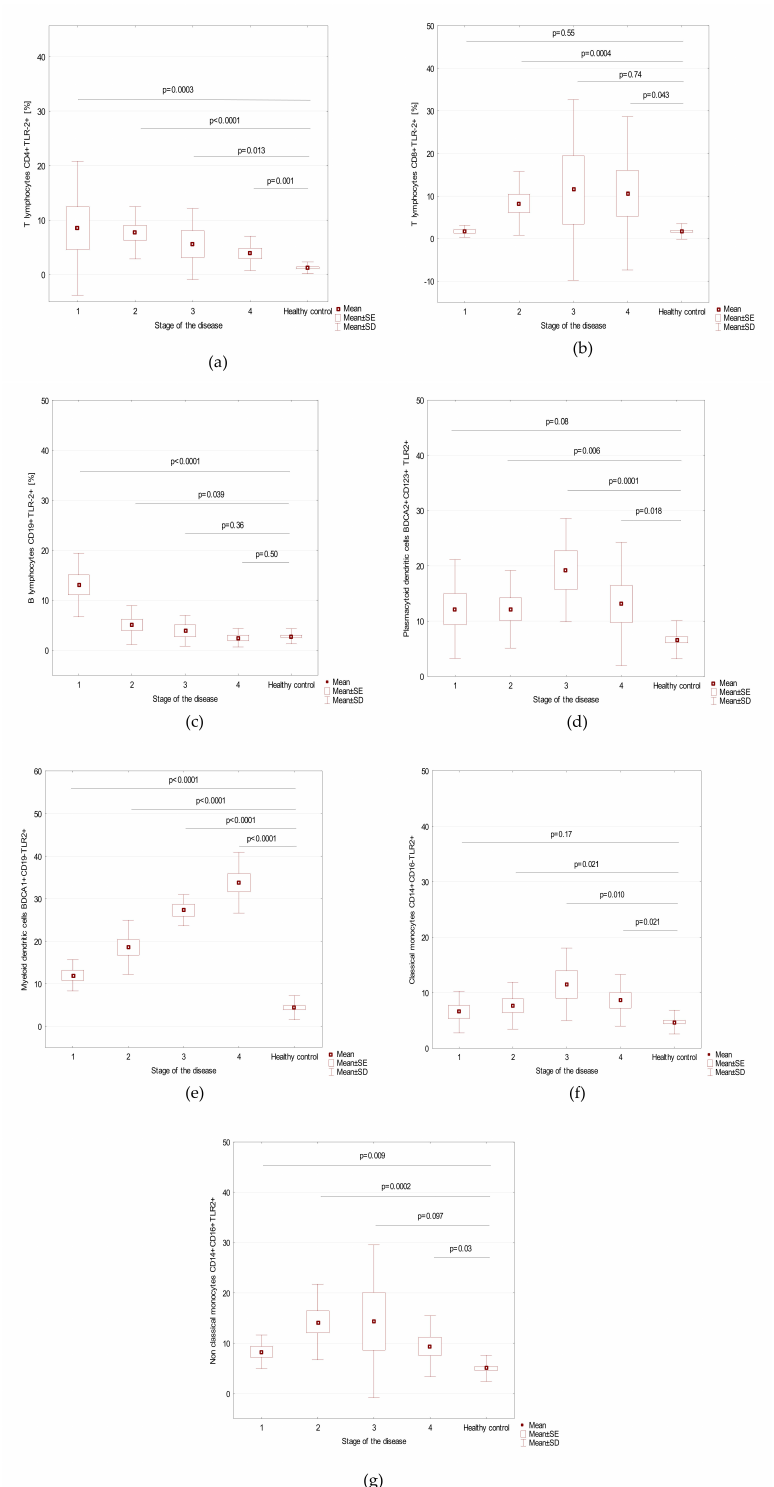
Figure 1. TLR2 + biomarkers in endometriosis patients with di ff erent stages of disease and in the control group. ( a ) T lymphocytes CD4 + TLR-2 + [%]; ( b ) T lymphocytes CD8 + TLR-2 + [%]; ( c ) B lymphocytes CD19 + TLR-2 + [%]; ( d ) Plasmacytoid dendritic cells BDCA2 + CD123 + TLR2 + [%]; ( e ) Myeloid dendritic cells BDCA1 + CD19-TLR2 + [%]; ( f ) Classical monocytes CD14 + CD16-TLR2 + [%]; ( g ) Non-classical monocytes CD14 + CD16 + TLR2 + [%]. Mean values are marked as squares, means ± standard errors as boxes, and mean ± standard deviation as